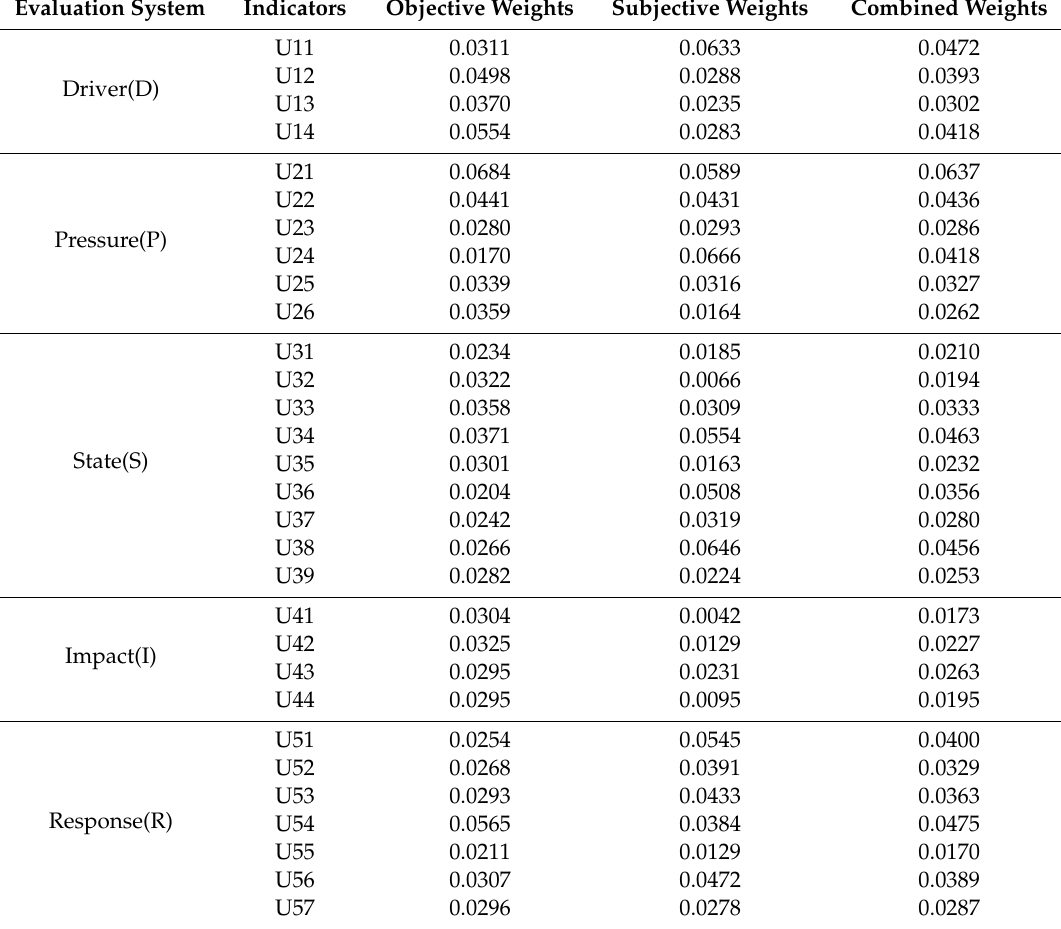
Table 3. Summary of the criteria